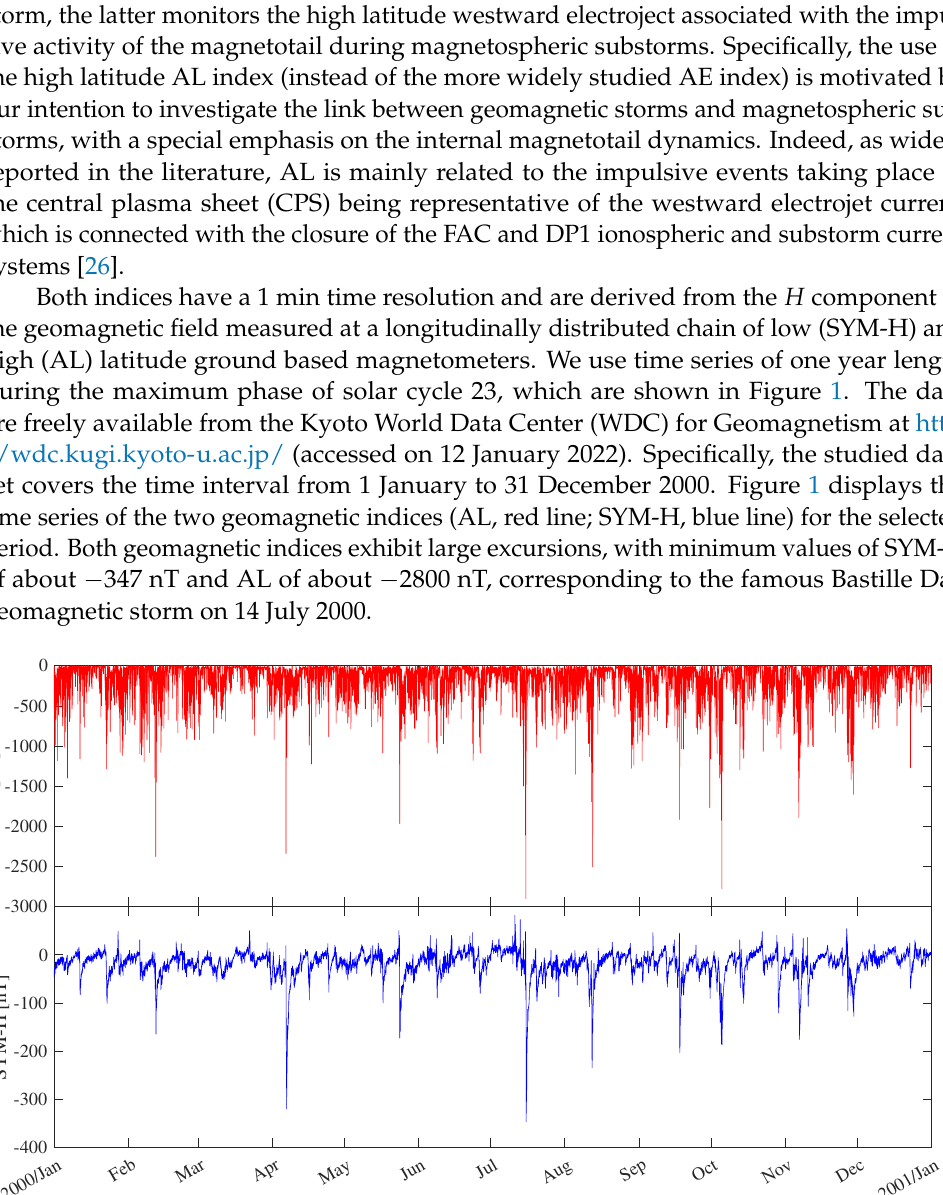
Figure 1. Time series of the high latitude geomagnetic index AL (upper panel) and low latitude geomagnetic index SYM-H (lower panel) from 1 January to 31 December